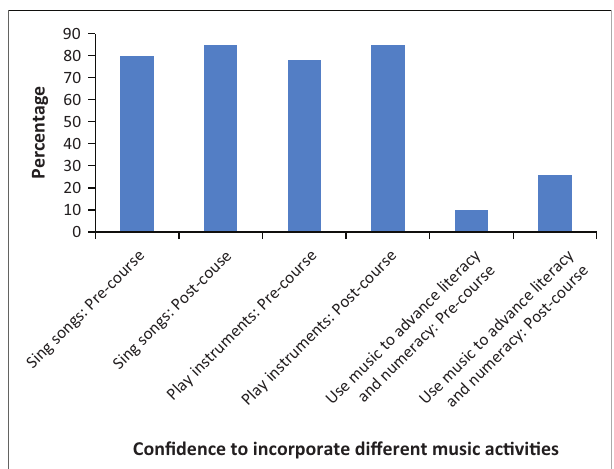
FIGURE 7: Pre-course and post-course confidence levels to teach different music activities.